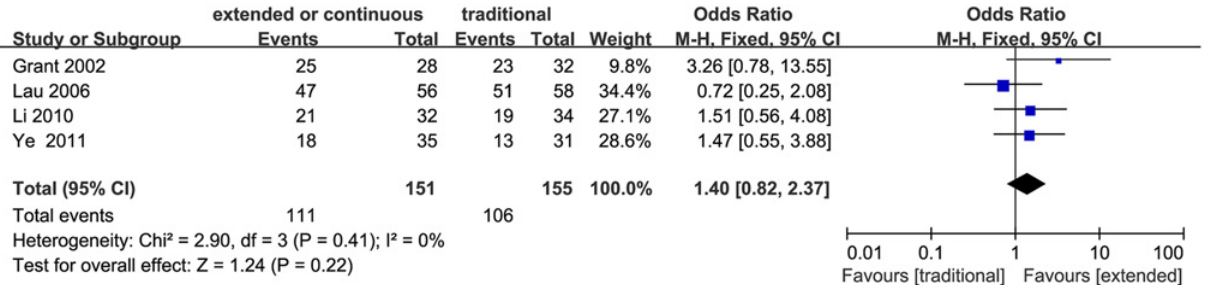
Figure 4. Forest plot depicting the odds ratios of bacteriologic success of patients receiving extended or continuous versus conventional intermittent infusion of